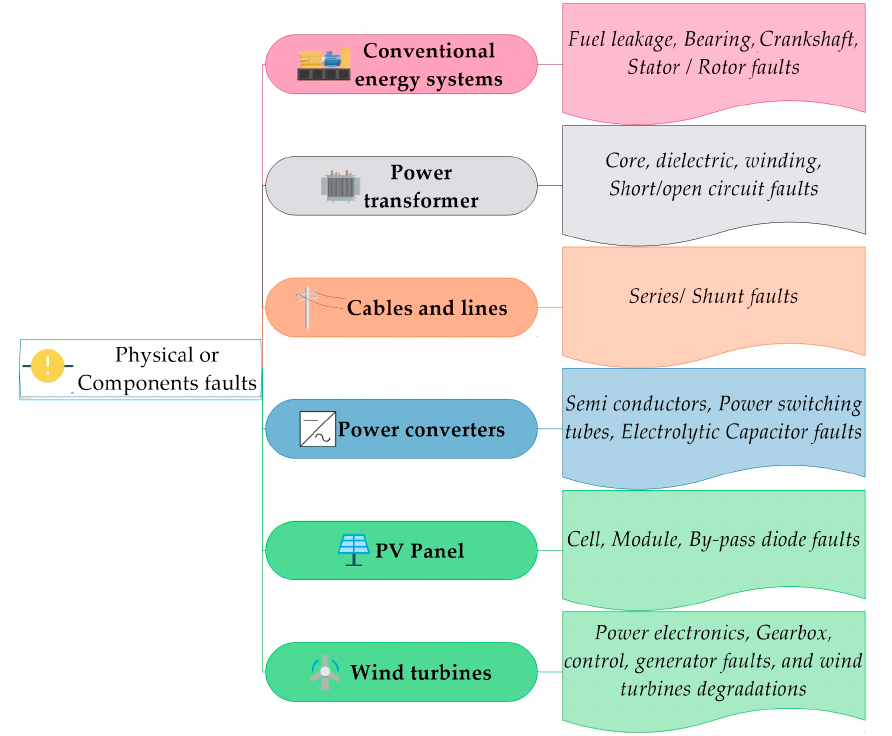
Figure 4. Types of power failures in SGs physical components [49].